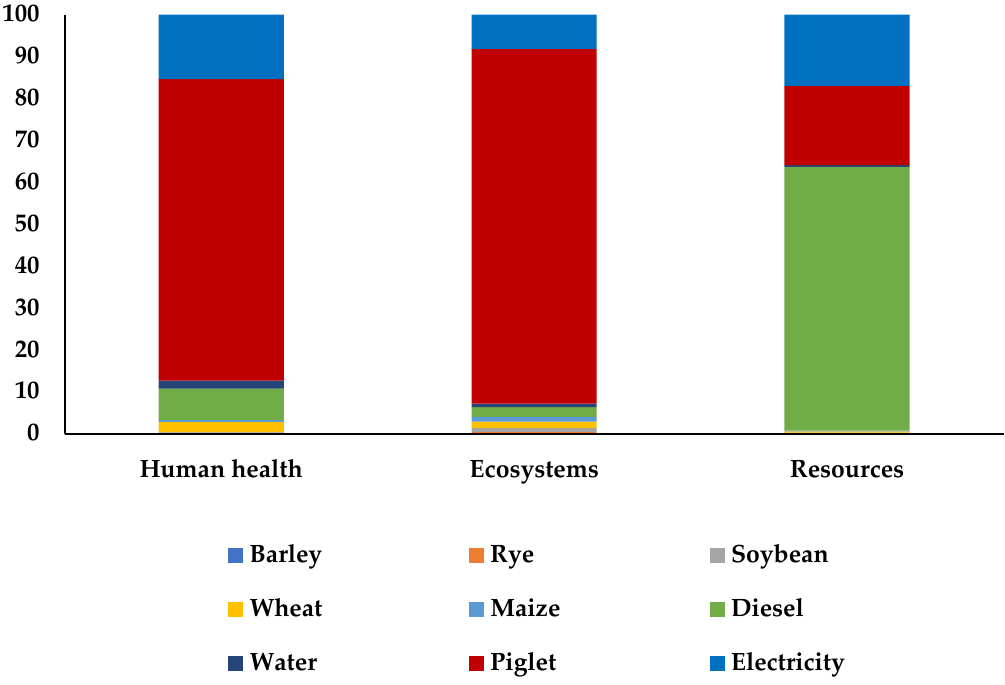
Figure 4. Characterized results for pork production considering the three macro-categories .